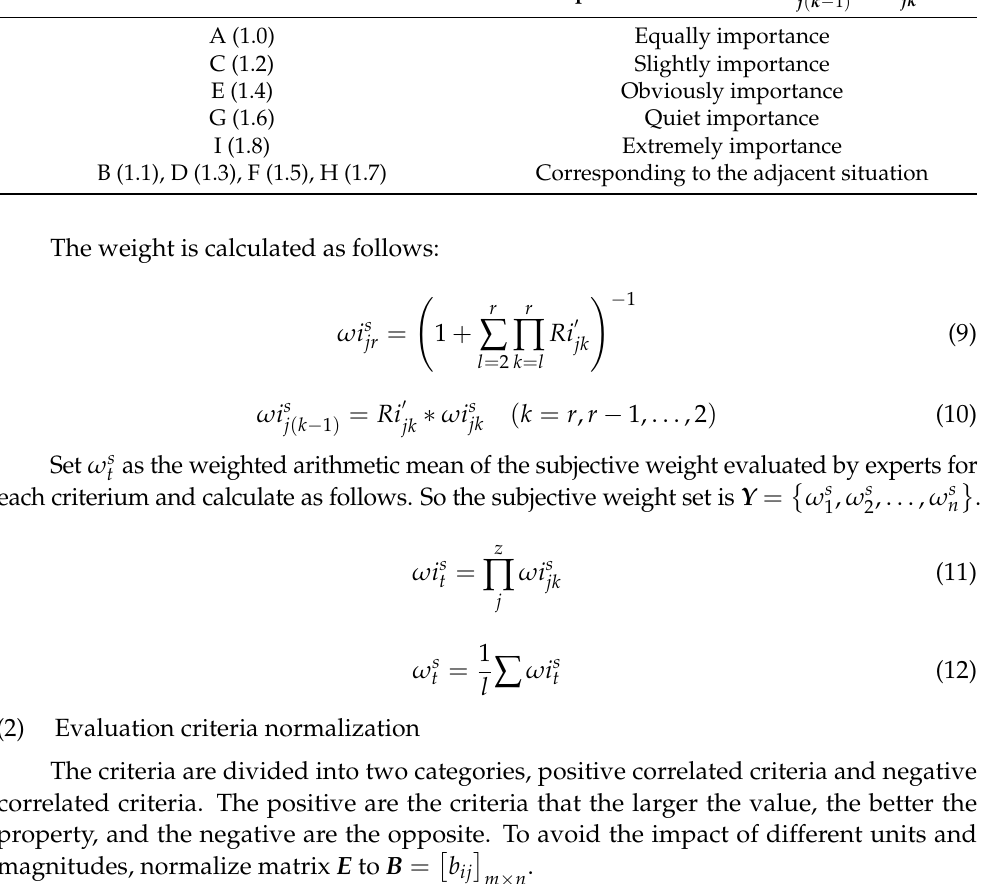
Table 1. The value range of Ri kj .